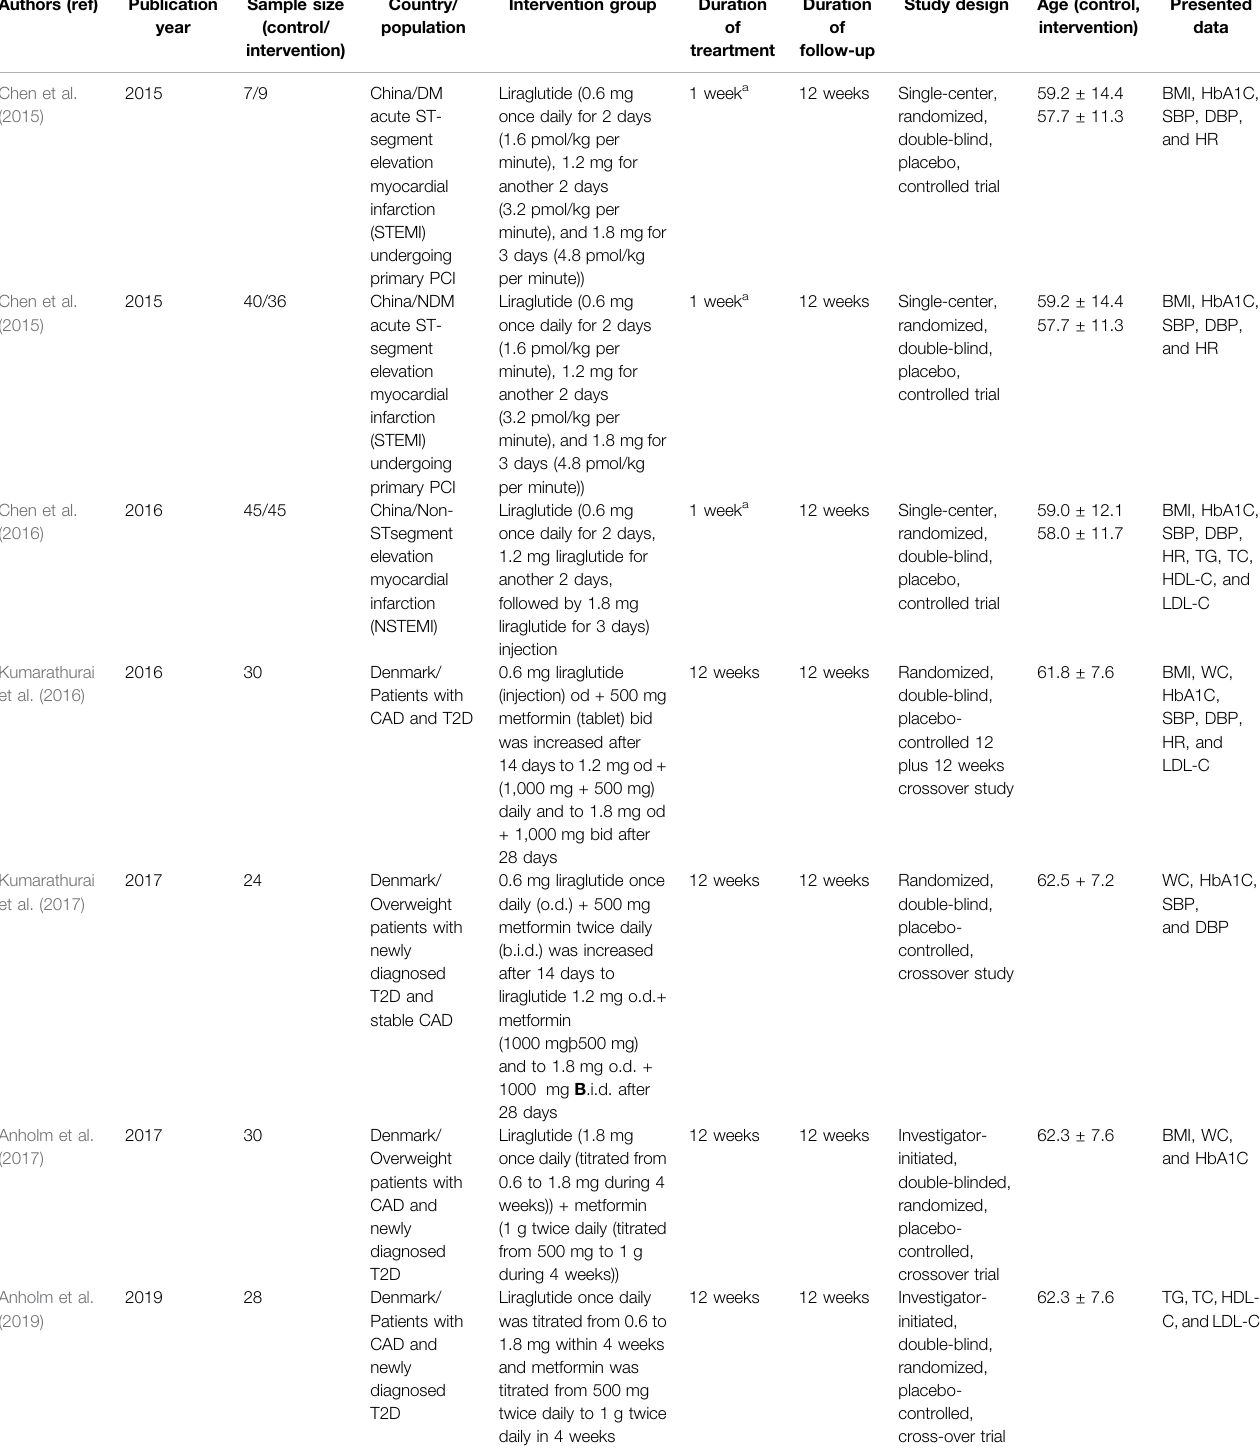
TABLE 1 | Characteristics of included